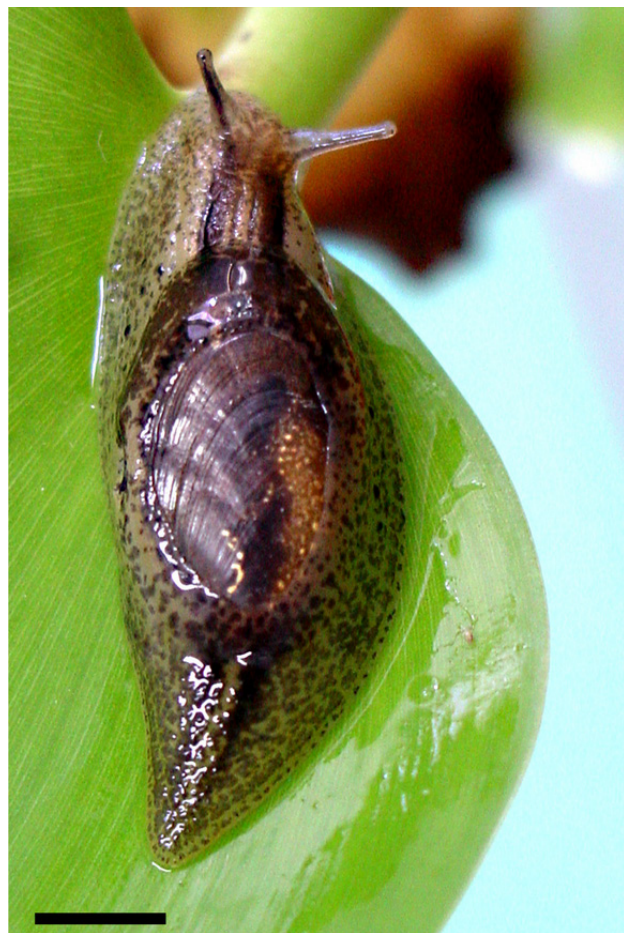
Figure 1. Omalonyx unguis Live specimen of on aquatic vegetation from Fazenda São Francisco, in Miranda, Mato Grosso do Sul State, Brazil. Scale bar = 5 mm. Photo: D. Omalonyx unguis , based on reports in the literature.